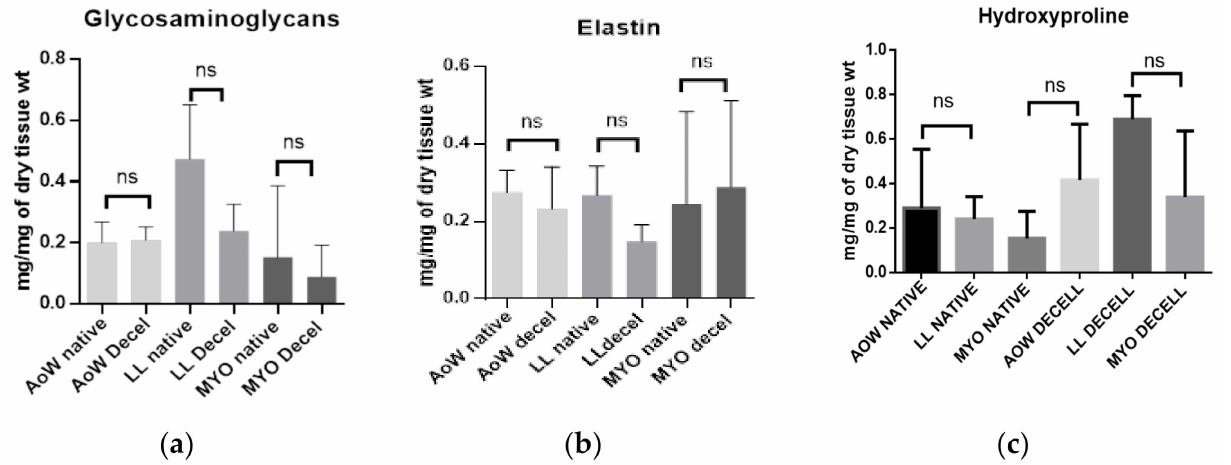
Figure 2. Biochemical analysis of ( a ) glycosaminoglycans, ( b ) elastin and ( c ) hydroxyproline shown. Native ( n = 3) and decellularized ( n = 3) samples were used for the analysis. Data were analyzed by one-way ANOVA ( p < 0.05). There was a non-significant (ns) difference between native and corre- sponding decellularized tissues. Increasing values of hydroxyproline are not statistically significant.